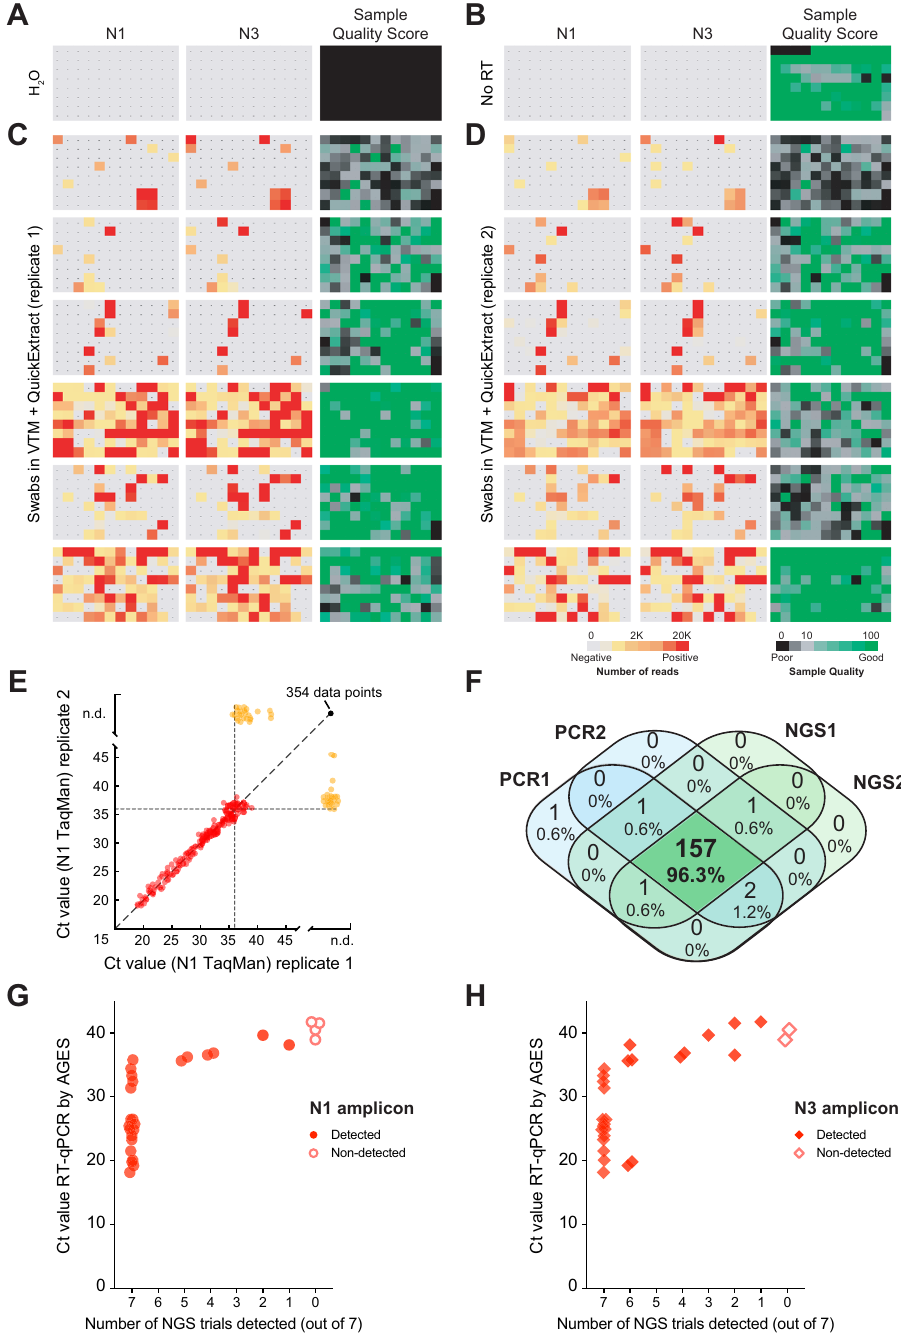
Fig. 4 SARSeq robustly detects SARS-CoV-2 in patient samples. A H 2 O control plate of SARSeq with three primer pairs, namely N1, N3, and ribosome in the presence of RTC as well as N1 and N3 scavenger spike-ins. B SARSeq on a gargle-QuickExtract plate in the absence of reverse transcriptase. No false- positive wells were detected. Sample QC scores high due to the absence of RTC reads while DNA templated ribosomal amplicon is observed. C Analysis of 576 samples obtained by swab and collected in VTM. D Independent replicate of C based on the same inactivated patient swab. Color codes depict read counts and sample quality score for C and D . E Two independent N1 TaqMan qPCR runs on samples used for C and D . Ct values of both runs are plotted against each other. Color code: red: sample scoring positive in both qPCR replicates, orange: sample scoring once, black: sample scoring negative. Stochastic and latest detection of SARS-CoV-2 at cycle 36. F Venn diagram of reproducibility for all samples scoring positive with Ct 36 or less for at least one qPCR replicate. G , H Comparison of NGS results by SARSeq to Ct values obtained by diagnostic qPCR. A set of 90 samples (including swabs and gargle in different buffers) was used for RNA extraction and qPCR measurements and in parallel aliquots of these samples were mixed either with QuickExtract or TCEP/EDTA and measured by SARSeq in triplicates and quadruplicates, respectively. We report the number of replicates in which we called a sample positive by NGS (with the N1 or N3 amplicon) relative to the qPCR Ct values. Not shown are 63 samples that were negative by qPCR and